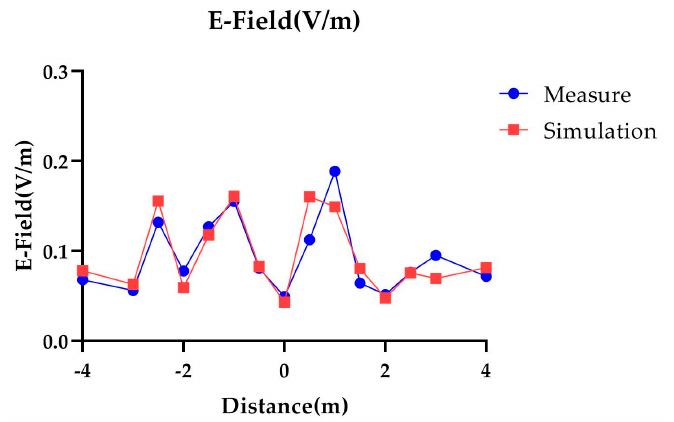
Figure 13. E-field estimation within a linear radial distribution, 0 ◦ orientation, cut plane height 1.7 m [13].